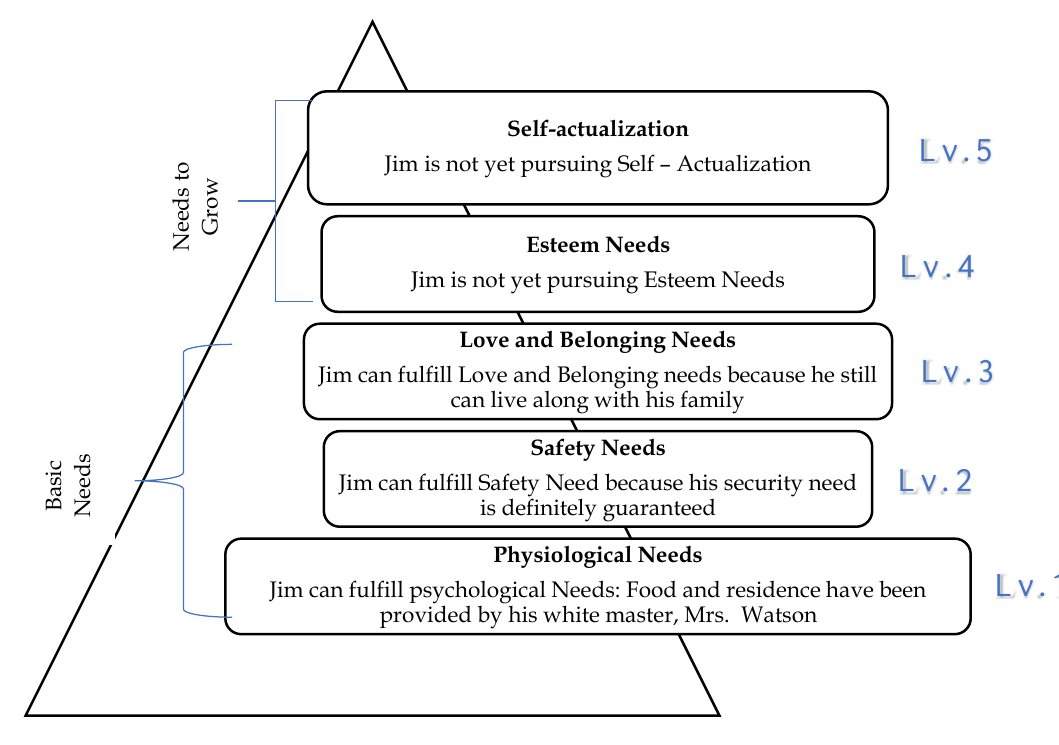
Figure 2. Phase 1 (At the beginning when Jim as a slave for his